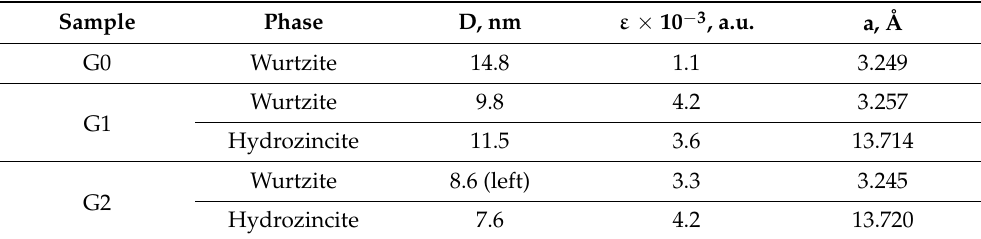
Table 1. Calculated values of the mean crystallite size (D), lattice strain ( ε ), and unit cell parameter (a) of the wurtzite and hydrozincite crystallographic